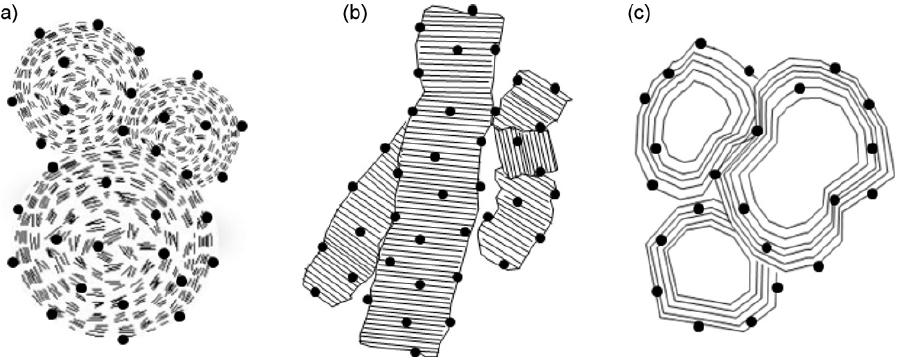
Fig. 1. The graphical presentation of three different types of carbon supported Pt particles, (a) Pt/CB, (b) Pt/CNF, (c) Pt/CNC. Figure 5. Three different types of carbon materials: ( a ) carbon black; ( b ) carbon nanofiber; ( c ) carbon nanocage. Reproduced with permission from [60]. Copyright Elsevier, 2009.